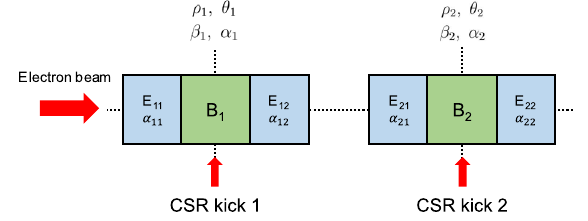
FIG. 25. Schematic view of the achromatic dog-leg transfer line with edge